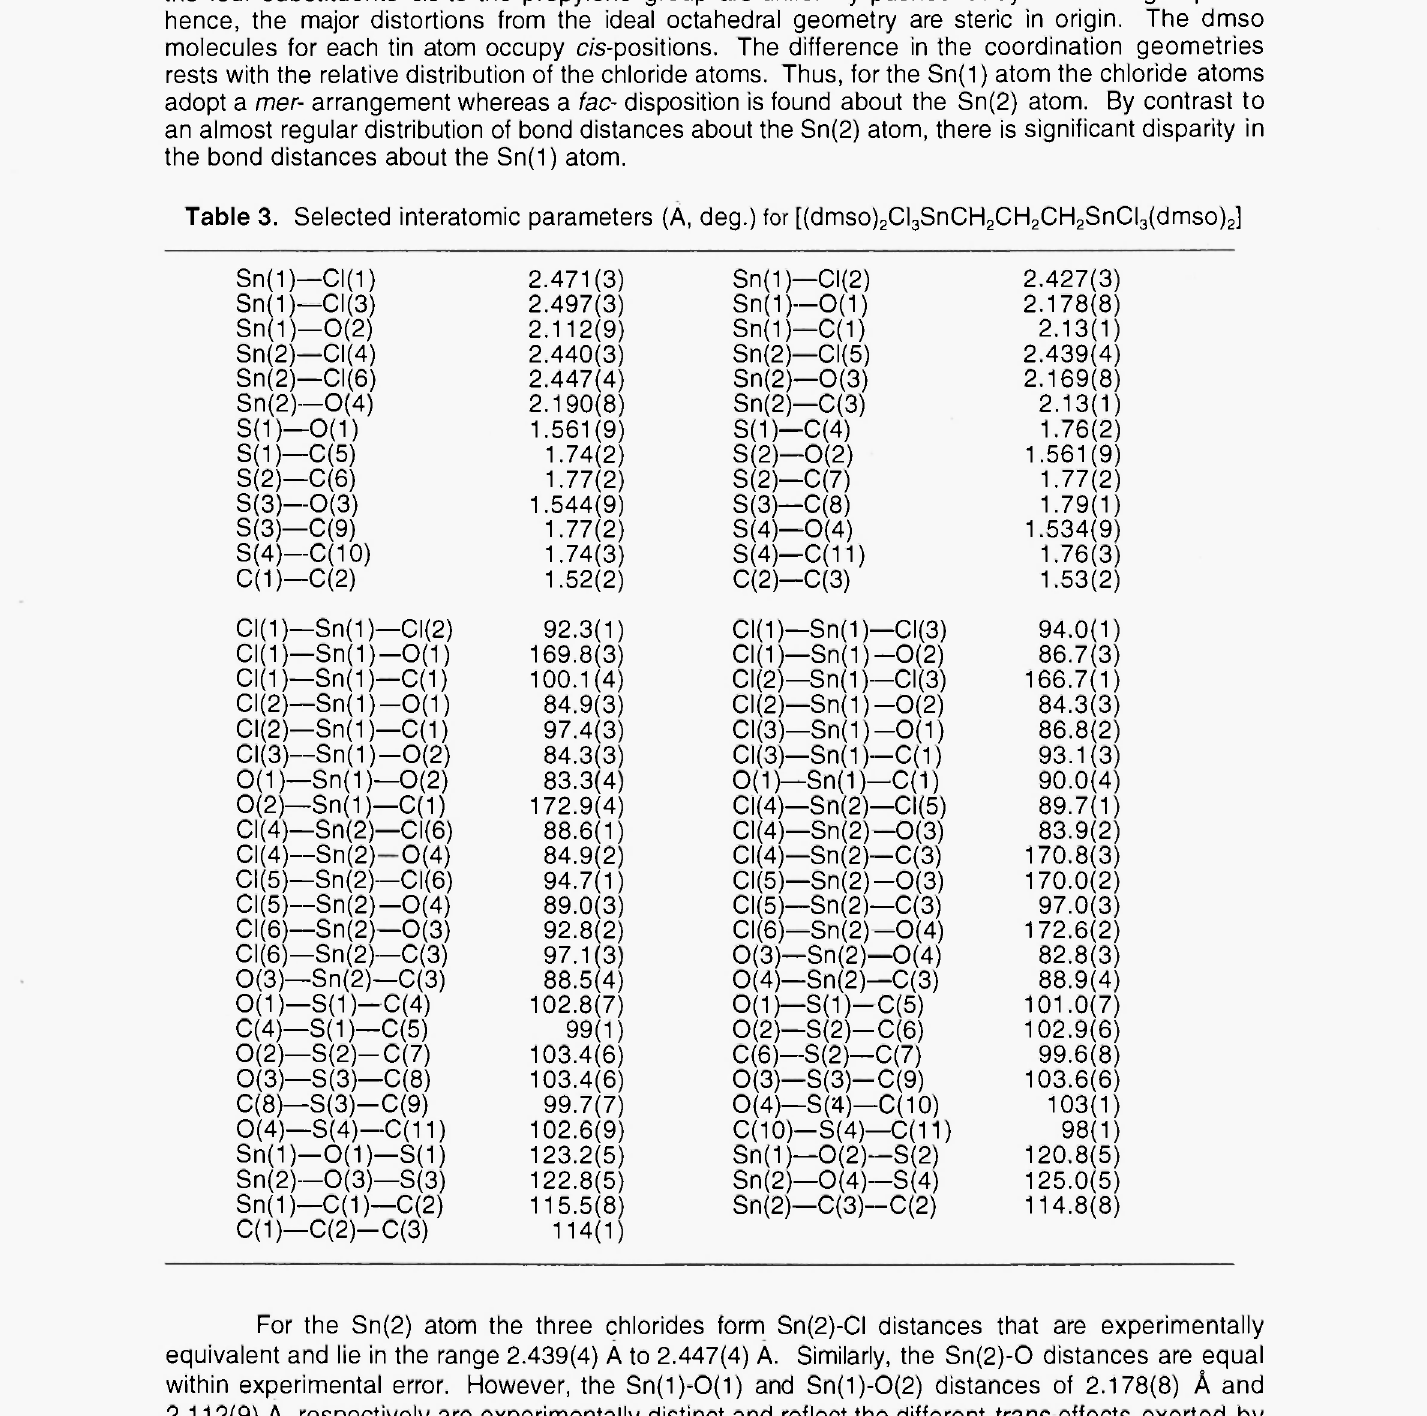
Table 3. Selected interatomic parameters (A, deg.) for [(dmso) 2 CI 3 SnCH 2 CH 2 CH 2 SnCI 3 (dmso) 2